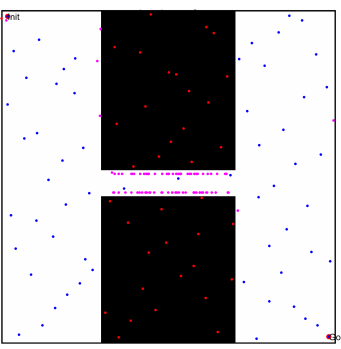
Figure 15. Optimization results of the obstacle points in the working